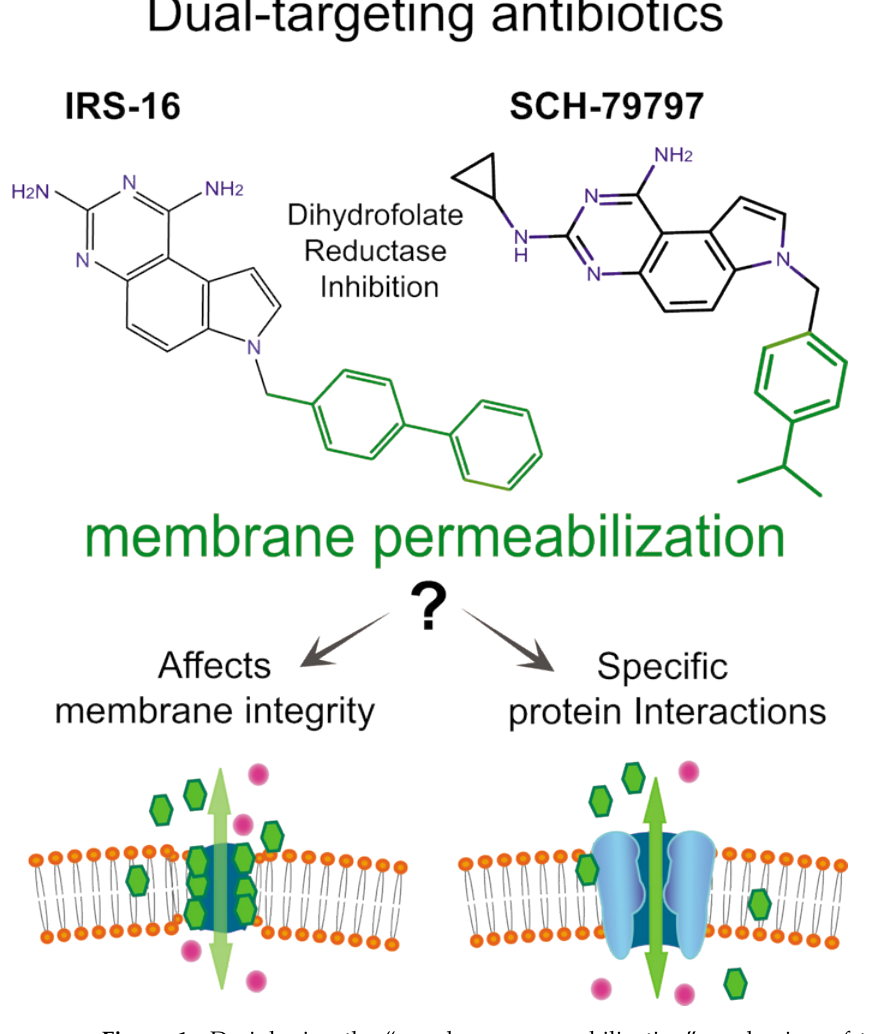
Figure 1. Deciphering the “membrane permeabilization” mechanism of two novel dual-target antibiotics. Structures of the antibacterial compound SCH-79797 and its derivative IRS-16 and their dual-targeting mechanism of action. The mechanisms of action of each component of the compounds have been described: one targeting the folate metabolism (black) by inhibiting the dihydrofolate reductase, and the other increasing membrane permeabilization (green). Here, we elucidate whether this latter effect is non-specific ( bottom left ) or dependent on the expression of bacteria-specific channels ( bottom right